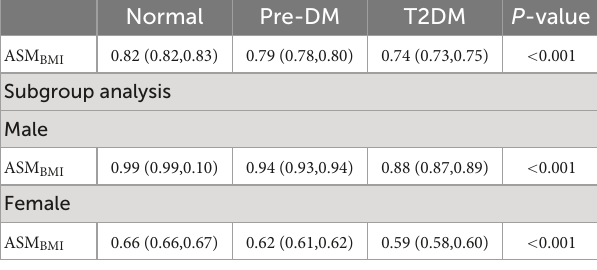
TABLE 3 The ASM BMI in different diabetes status populations included in the study.